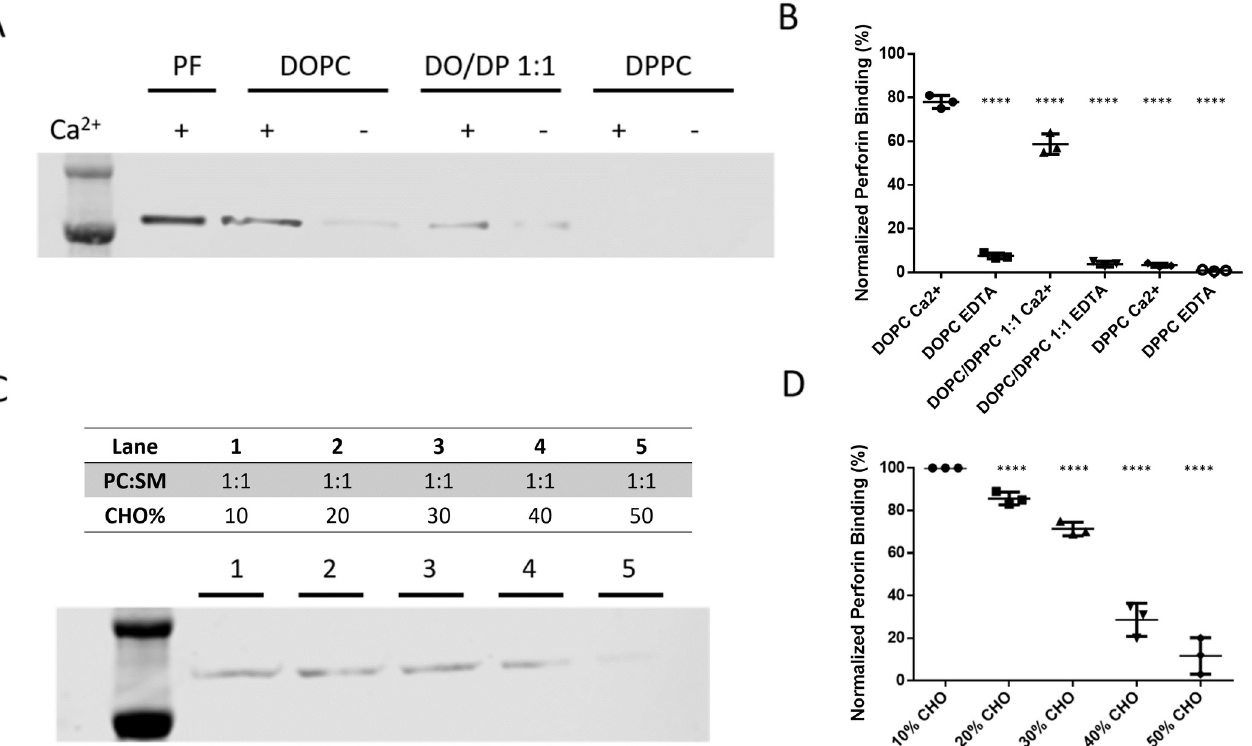
Fig 5. Perforin membrane binding is prevented by the presence of densely packed lipid. Differently packed liposomes were created by either pure or a ratio of DOPC and DPPC, which were coincubated with perforin. Levels of membrane-bound perforin were evaluated by western blot analysis (A, representative of 3 independent repeats). Since membrane binding of perforin requires the presence of Ca ++ , this was either added at 20 mM concentration or depleted as specified in the blot and quantification. As a control, pure perforin (PF) was evaluated without liposomes. Three independent experiments were performed, and the quantitative values for each via densitometry were plotted with mean ± SD shown (B). Using Student t test, the mean values were different from DOPC Ca + + p < 0.0001, ���� (C) Differently packed PC:SM:CHO liposomes were created with 1:1 PC:SM and increasing percentages of CHO (as specified above each lane) and coincubated with perforin in the presence of Ca ++ . Levels of membrane-bound perforin were evaluated by western blot analysis using anti-perforin antibody (clone D48) (representative result shown). Three independent experiments were performed, and the quantitative values for each via densitometry were plotted with mean ± SD shown (D). Using Student t test, the mean values were different from 10% CHO p < 0.0001, ���� . CHO, cholesterol;